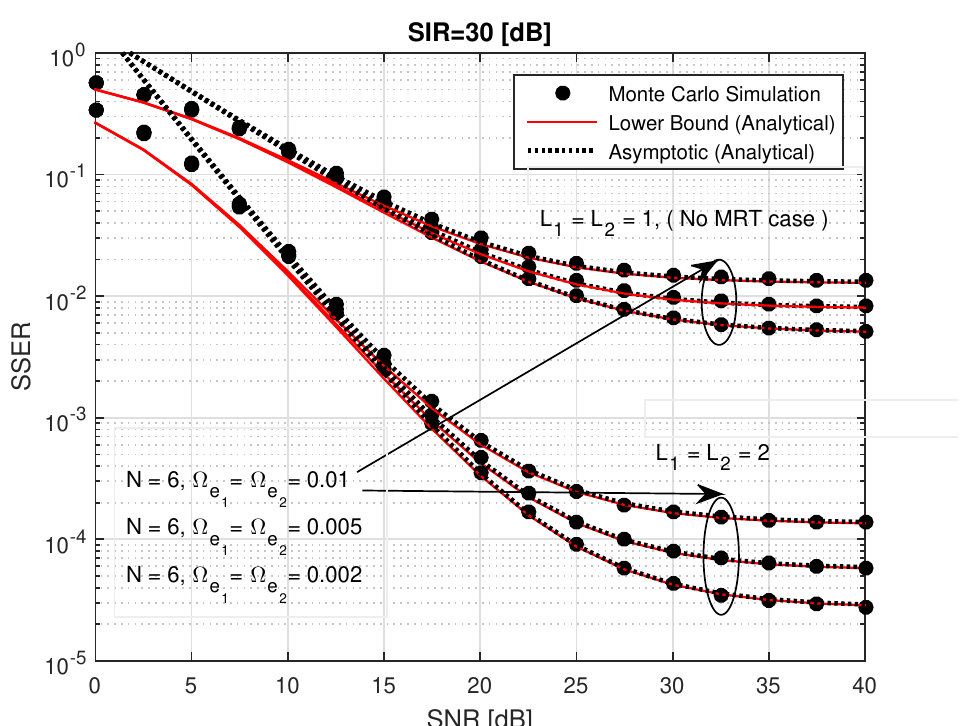
Figure 11. Sum SER performance of AF-TWRN with different number of antennas, different values of CEE, P / P I = 30 dB and N =